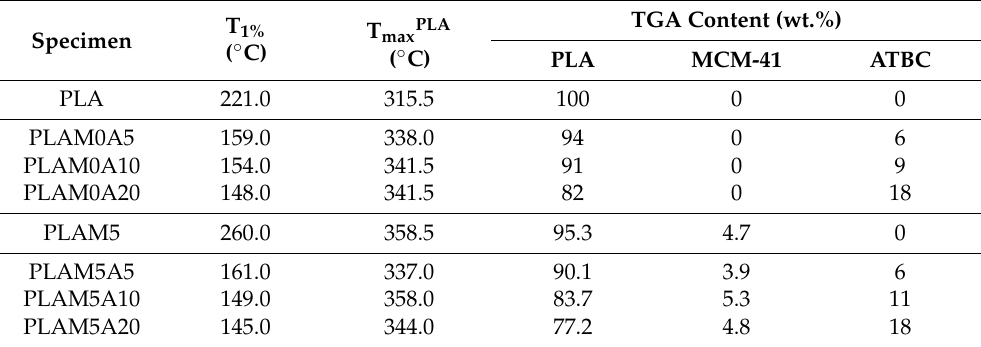
Table 2. Results derived from TGA experiments performed under air: temperature for 1% degradation (T 1% ), the maximum degradation temperature (T maxPLA ) and the actual material content based on TGA analysis for the different constituents: PLA, ATBC plasticizer and MCM-41 silica. Specimen